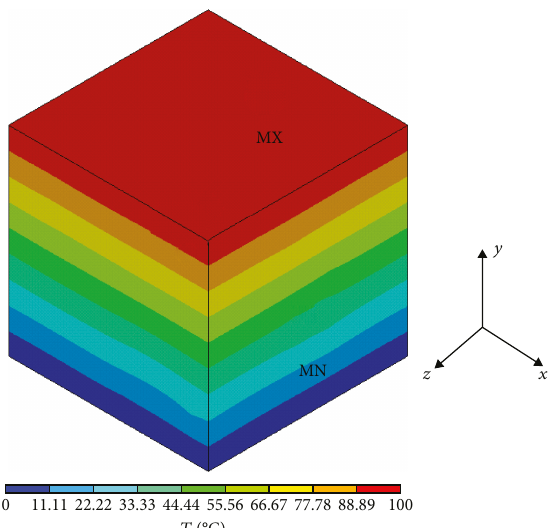
Figure 33: Temperature distribution of depositing on the fi ber with the carbon